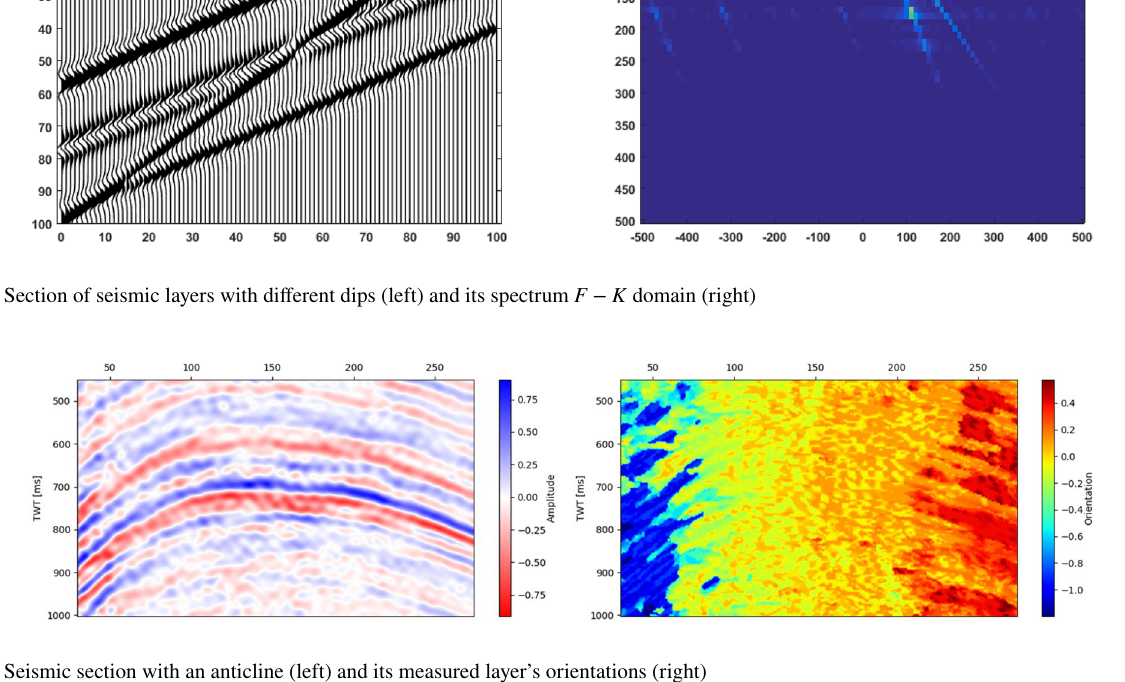
Fig. 3 Seismic section with an anticline (left) and its measured layer’s orientations (right)